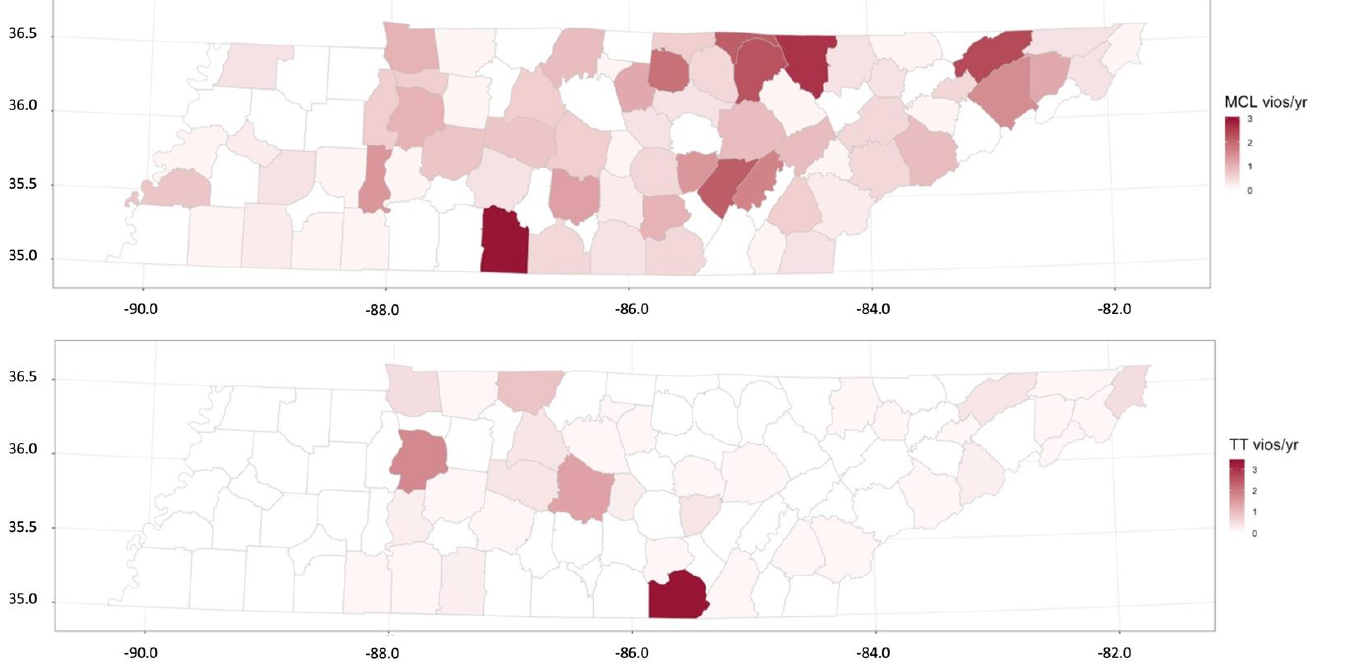
Figure 7. Maps of maximum contaminant level (MCL) violations and Treatment Technique (TT) violations per county per year. Note: MCL and TT violations are health-based violations according to the EPA definition. The MCL maps shows slight spatial clustering patterns (Moran’s I = 0.022, p -value = 0.02). The x axis is longitude, the y axis is latitude. Table 3. Counties with the highest values of different types of violations and